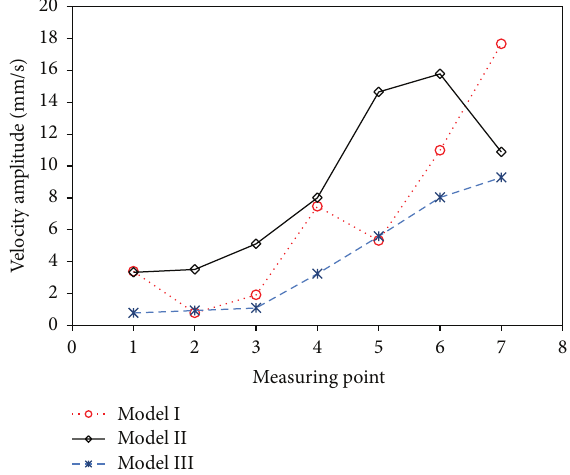
Figure 9: Velocity intensities of V 1 –V 7 for Models I, II, and III subjected to base excitation at 𝑓 1